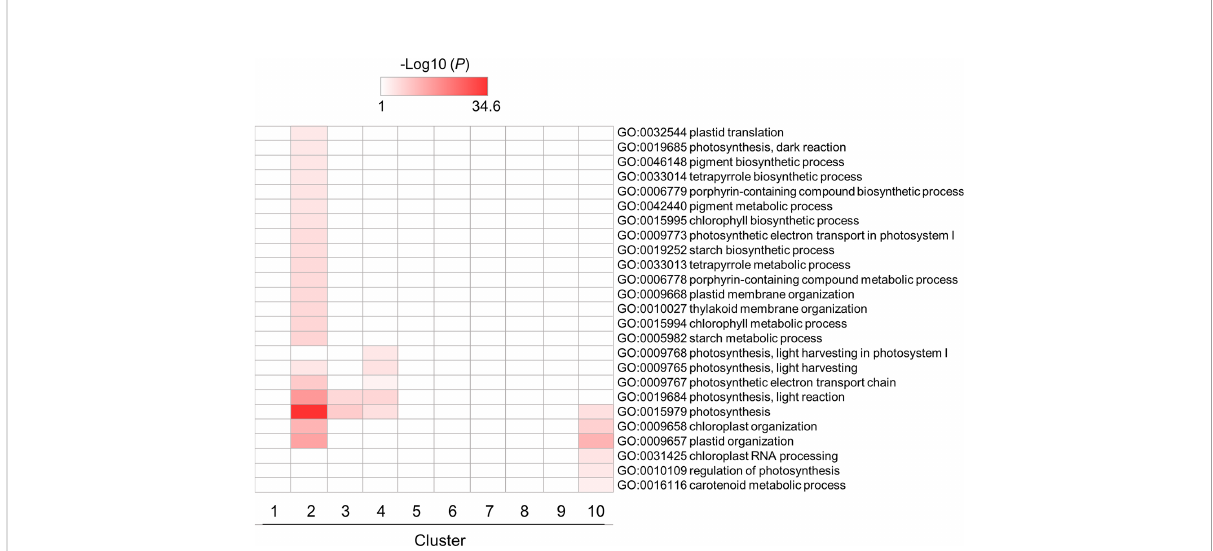
FIGURE 5 GO enrichment analysis of chloroplast- and photosynthesis-related DEGs identi fi ed in fl g22-treated Brachypodium distachyon leaf disks. The p -values of 25 GO terms in each cluster were analyzed, converted to logarithmic values (-Log10), and represented as a heatmap, with darker colors indicating